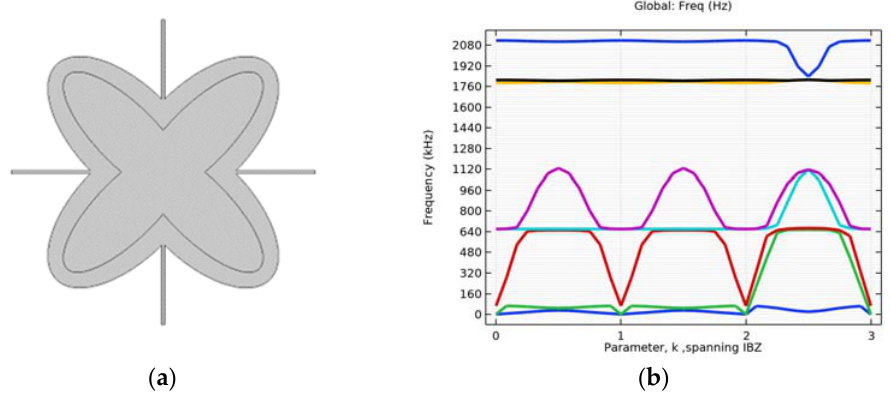
Figure 8. Response for inner ellipse 170 × 60, rod 3 mm. (a) microstructure, (b) responce for first eigenfrequenciew. Two band gaps are shown, between 5th and 6th eigenfrequency (1120–1775 Hz) and between 7th and 8th eigenfrequency (1805–1835 Hz).